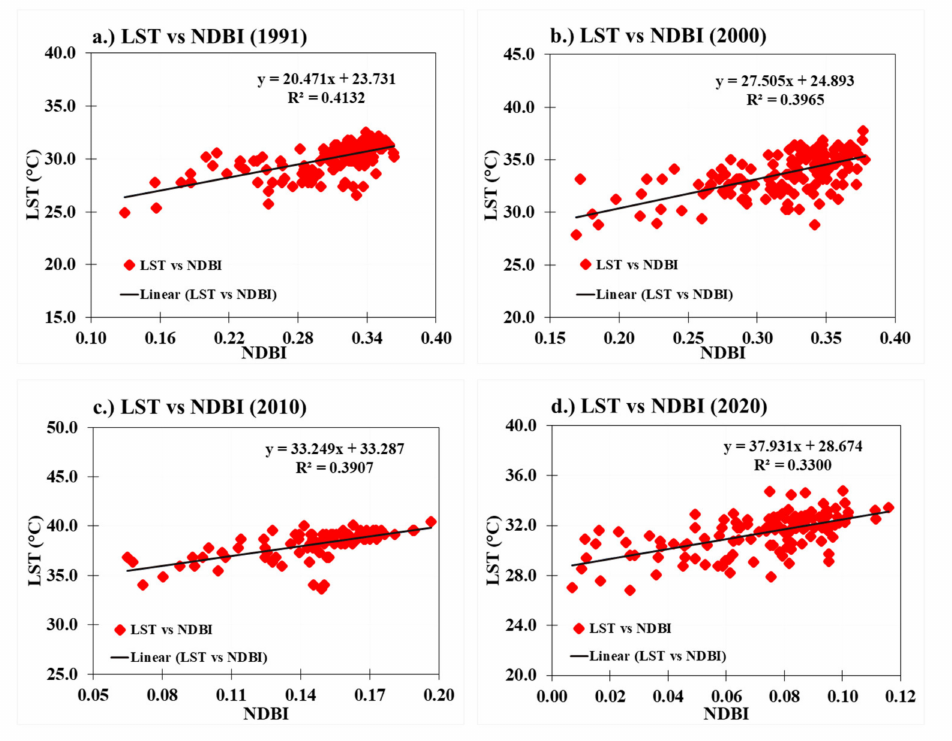
Figure 13. Correlation between LST and NDBI for the years ( a ) 1991, ( b ) 2000, ( c ) 2010, and ( d )